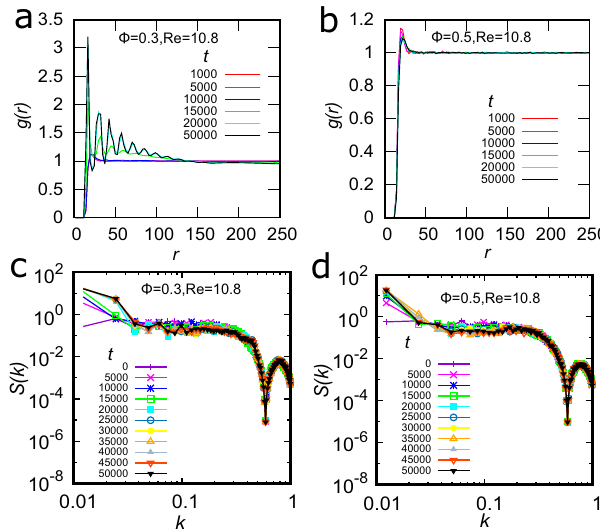
Fig. 3 Characteristics of phase-separated fi nal states at t = 50000. Streamlines ( a ) and Magnus forces ( b ) for an off-symmetric composition (OSM) ( Φ = 0.3, Re = 10.8). Streamlines ( c ) and Magnus forces ( d ) for a symmetric composition (SM) ( Φ = 0.5, Re = 10.8). The big arrows in a and c show the fl ow directions. We show the iso-velocity lines together with fl ow vector fi elds in a and c . The colour bars in b and d show the Magnus force ’ s magnitude, and the arrow shows its direction and magnitude. See Fig. 2a and b at t = 50000 for the corresponding particle distributions and the velocity fi elds.